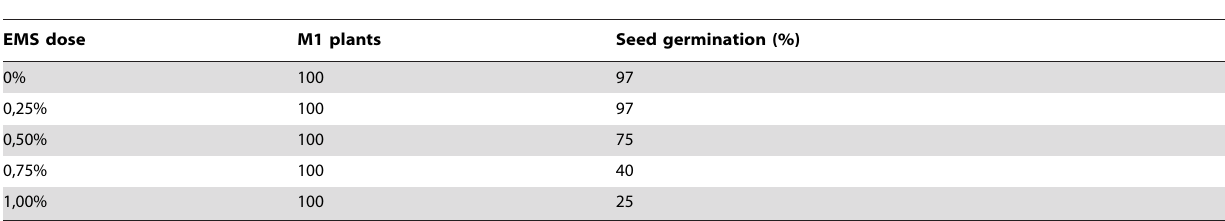
Table 1. Impact of EMS concentration on seed germination.